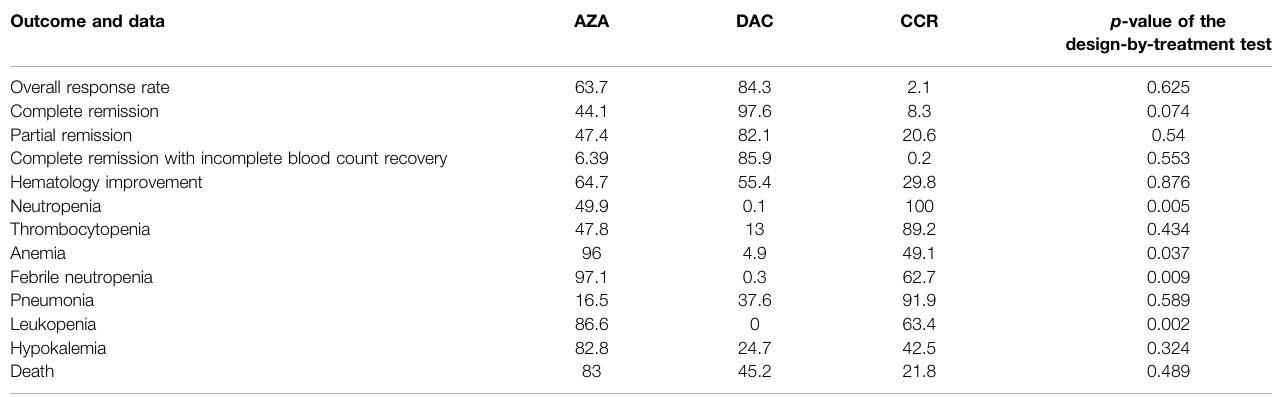
design-by-treatment test